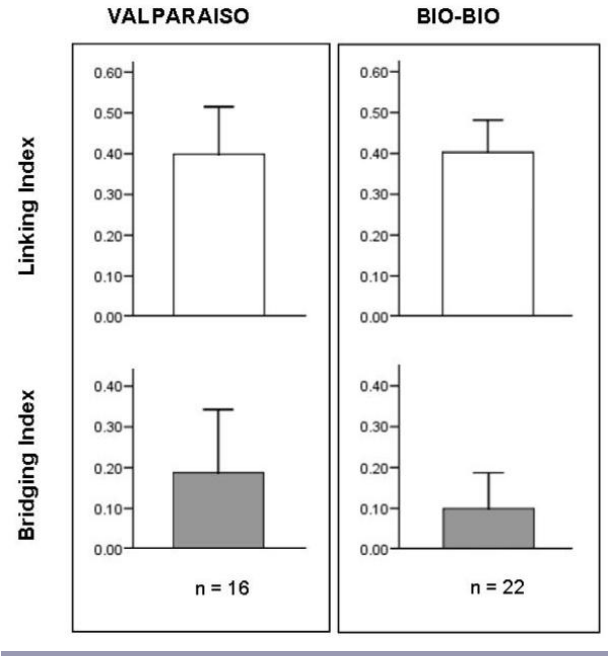
Fig. 2 . Mean linking and bridging social capital scores of fisher organizations involved in comanagement in the Valparaíso and Bio-Bio Regions. Differences between means are not statistically significant, suggesting a common pattern of linking and bridging egocentric comanagement networks of fisher organizations in both